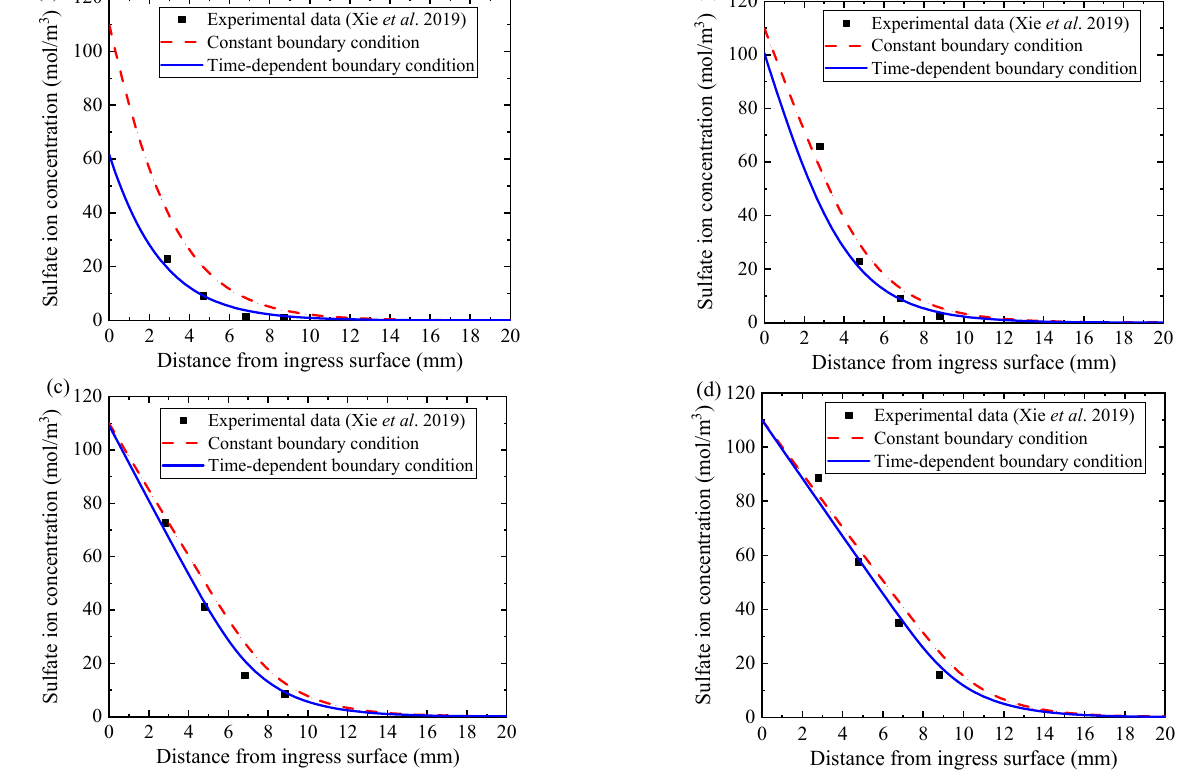
Figure 7. Sulfate ion concentration distribution profiles of the experimental results of Xie et al. [13] and simulation results on different ingress time: ( a ) 30th day, ( b ) 90th day, ( c ) 180th day, and ( d ) 270th day, respectively.